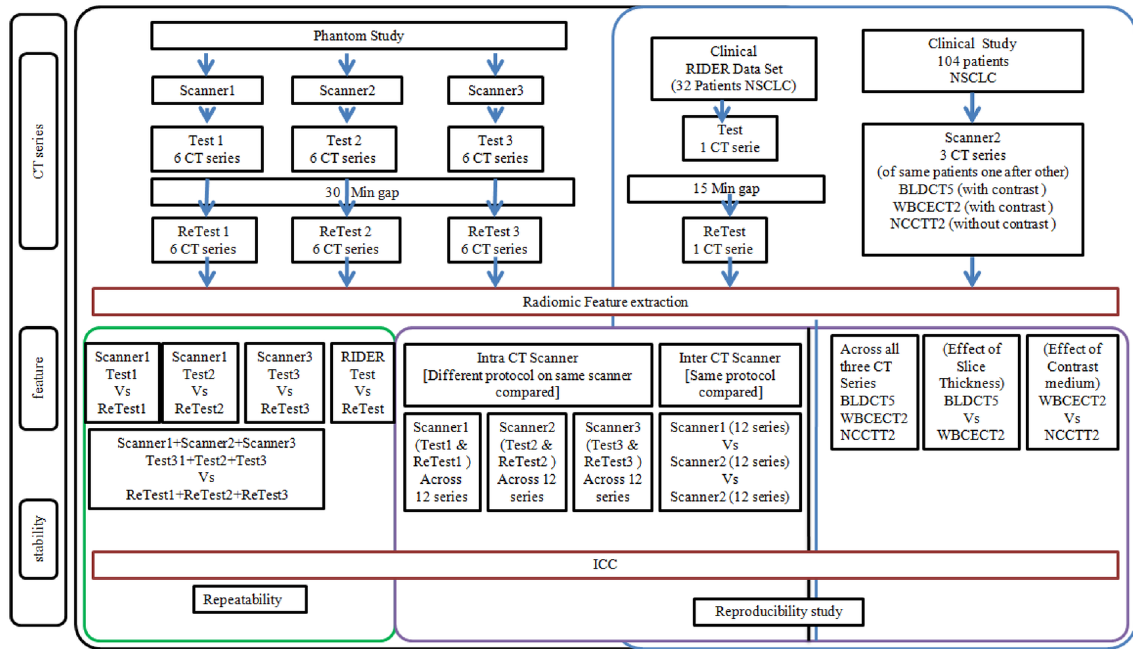
Figure 5. In this study we investigated both reproducibility and repeatability of radiomic features. The repeatability of radiomic features was evaluated using the test retest scans acquired with the IQ phantom on three different scanners and with 6 protocols and online available RIDER data set. The reproducibility of radiomic features with respect to different acquisition protocols but within the same scanner (intra-scanner variability) was evaluated comparing radiomic feature values using the test–retest scans acquired with the IQ phantom across the 6 different protocols. A clinical cohort of NSCLC patients was used to investigate the reproducibility of radiomic features with respect to 3 different clinical acquisition protocols, with a focus on the impact of slice thickness and IV contrast